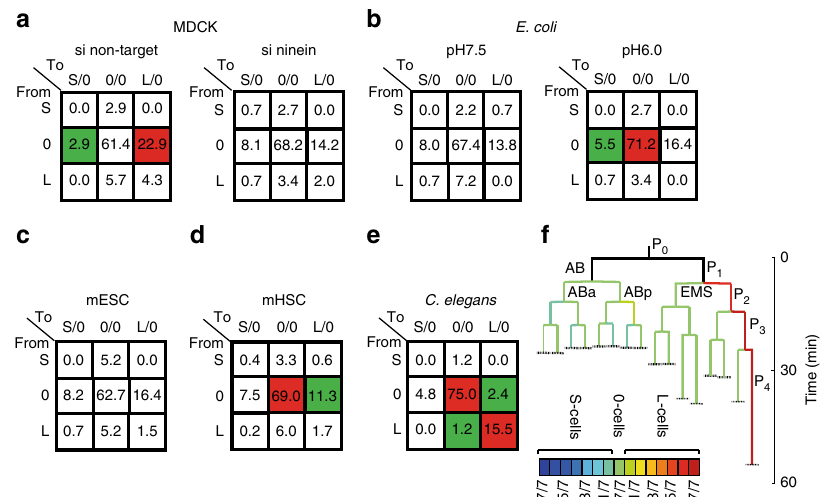
Fig. 5 Propagation of cell cycle duration variability is present in diverse not siRNA-treated cell systems revealing a physiological relevance for outlier cells. Frequencies of the division types and result of the propagation tests for a MDCK si non-target and si ninein, b E. coli grown at pH 7.5 and pH 6.0, c non- differentiating mouse embryonic stem cells (mESC), d differentiating mouse haematopoietic stem cells (mHSC) and e developing C . elegans embryos. Colour code as Fig. 3. a – e Colour-coded matrix fi elds: red — most likely overrepresented, green — most likely underrepresented division types. Absolute number of divisions per model system in Supplementary Table 1. Matrices with absolute values in Figs. 3f, 4a and Supplementary Figures 9, 11 – 15. f An averaged lineage tree based on median cell cycle durations of seven C. elegans developments up to generation 5 is shown with the C. elegans typical cell names. Line colours indicate the frequencies of 0-cells (green), L-cells (green to red) and S-cells (green to blue) as de fi ned in the left heatmap referring to the empirical frequency of individual cell types within the seven C. elegans lineage trees; black line, if granddaughter sets were not